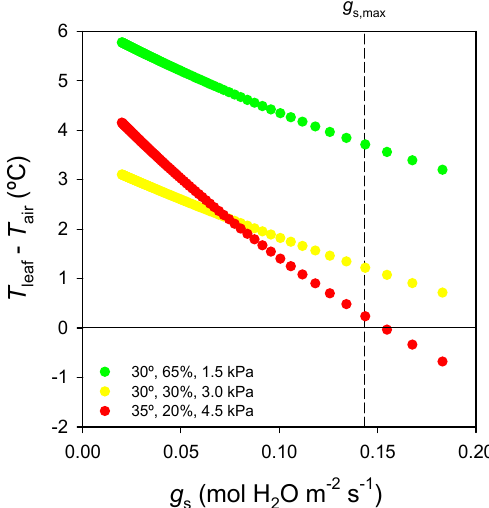
Figure 7. Relationships between leaf stomatal conductance ( g s , mol H 2 O m − 2 · s − 1 ) and the di ff erence between leaf and air temperature ( T leaf − T air , ◦ C) for Q. coccifera . T leaf was obtained applying the Leaf Energy Balance Program by Kevin Tu, U.C. Berkeley (www.landflux.org / resources / Ecofiz_Tleaf_ K2_v3.xls) for windspeed = 1 m · s − 1 , short-wave radiation = 600 W · m − 2 and leaf length = 1.1 cm. We have considered three di ff erent climatic conditions regarding T air ( ◦ C) and relative humidity (RH, %): 30 ◦ C / 65%, 30 ◦ C / 30%, and 35 ◦ C / 20%. Maximum stomatal conductance ( g s,max ) for Q. coccifera was established according to Peguero-Pina et al. Table 2. Leaf overheating ( T leaf − T air , °C), leaf temperature ( T leaf , °C), and leaf transpiration ( E , mmol H 2 O m − 2 s − 1 ) when stomatal conductance is g s,max for Q. coccifera under different levels of vapor pressure deficit (VPD, kPa) according to the climatic conditions considered (see Figure 7 for details). VPD (kPa)